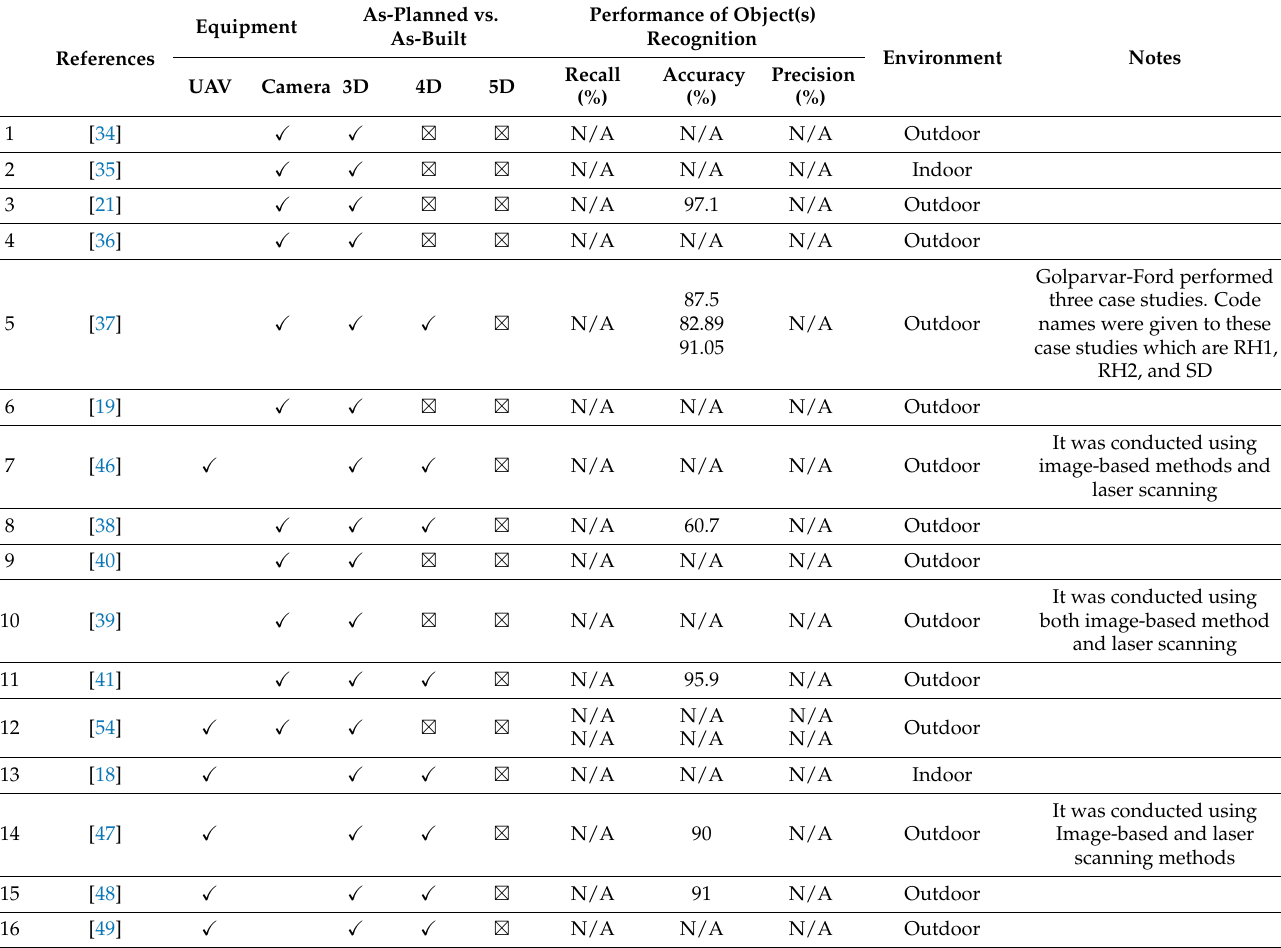
Table 5. Studies of image-based methods integrated with BIM CPM: